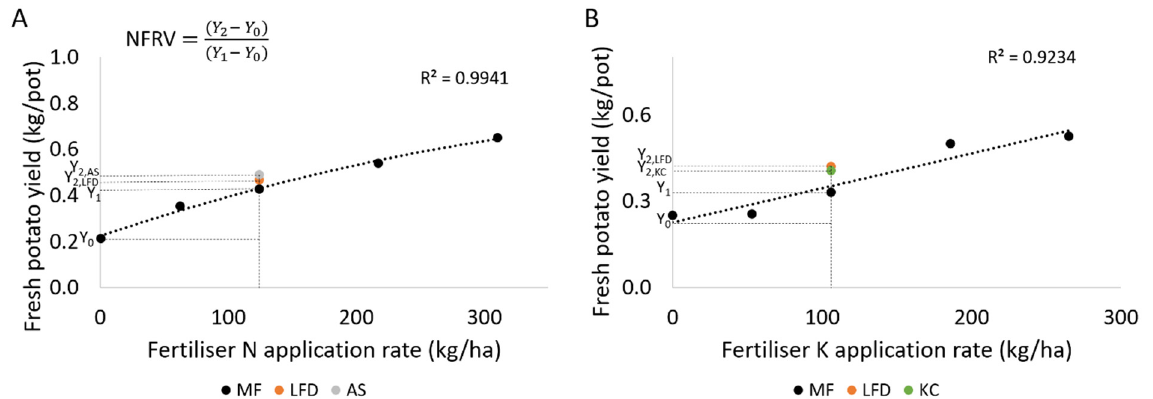
Figure 5. The yield response curves of mineral fertiliser N ( A ) and K ( B ) together with the performance of the liquid fraction of digestate (LFD), the ammonium sulphate solution (AS), and the K-concentrate (KC). Y 0 is the yield obtained from the yield curve when no mineral fertiliser is applied, Y 1 is the yield obtained from the yield curve when a fixed amount of mineral fertiliser is applied, and Y 2 is the yield obtained from the treatment that received BBF.